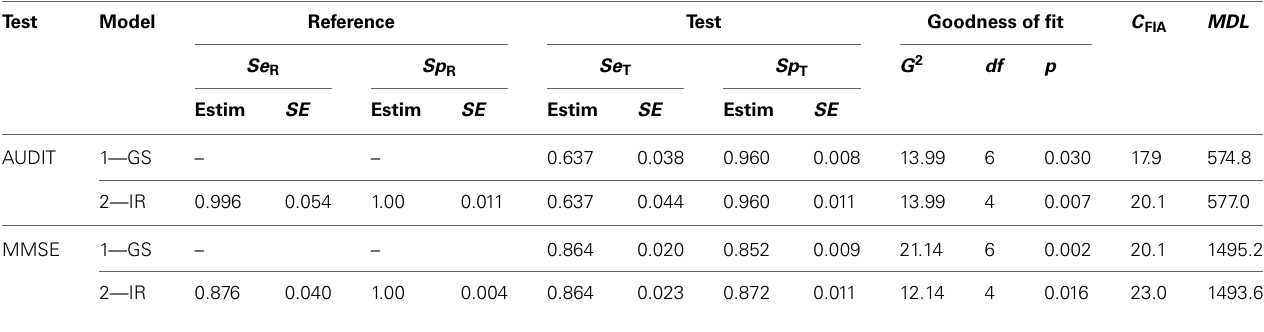
Table 3 | Parameter estimates, goodness-of-fit and Minimum Description Length of the two models for the AUDIT and the MMSE data. Test